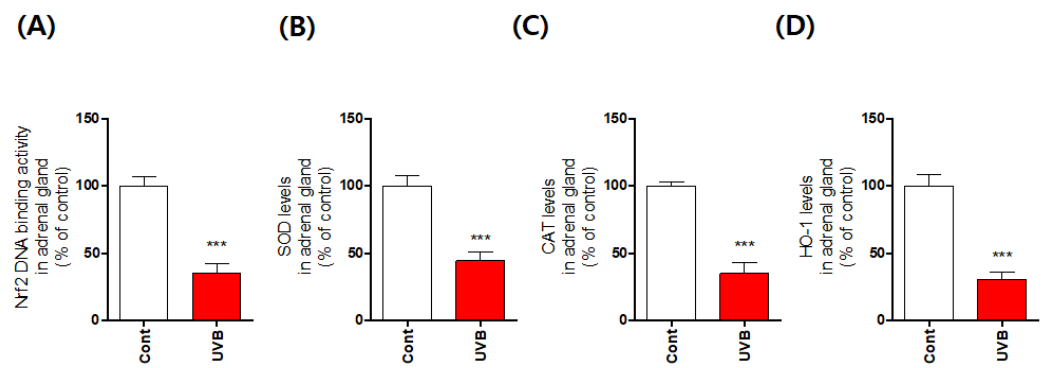
Figure 3. Reduction in expression levels of oxidative defense enzymes in the adrenal medulla induced by mouse skin exposure to chronic excessive UVB. The levels of Nrf2 ( A ), SOD ( B ), CAT ( C ), and HO-1 ( D ) were quantified using ELISA kits. Values represent the mean ± standard error of the mean. *** p < 0.001 compared with the control group.